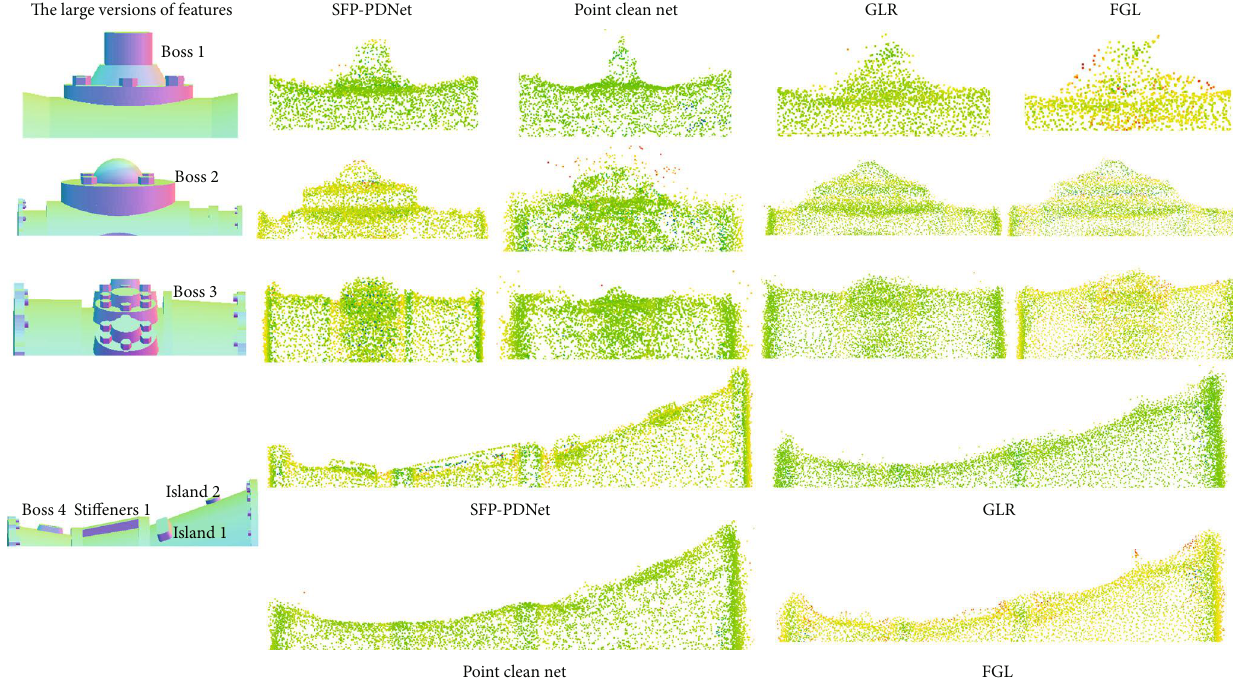
Figure 25: The larger versions of features. From up to down are casing 1, 2, 3, 4.